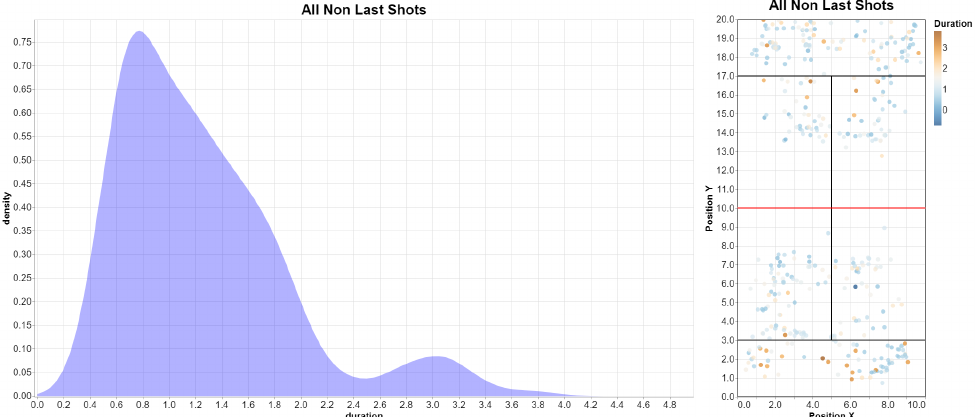
Figure 13. Distribution of the shot duration (s) for a test match ( left ), and position of the players for each shot ( right ), colored by shot duration. One half of the shots had a duration below 1.1 s.